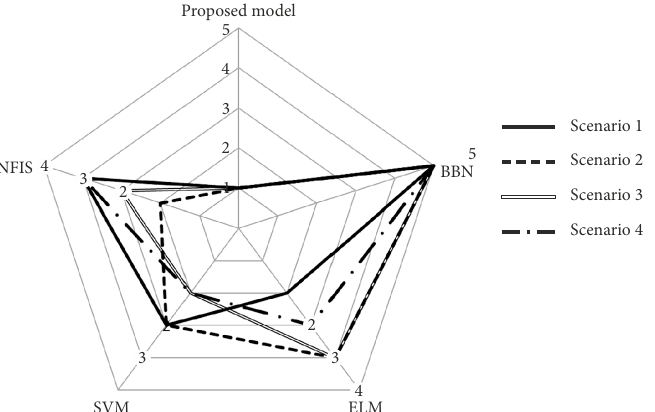
Figure 6. The result (100-Type II